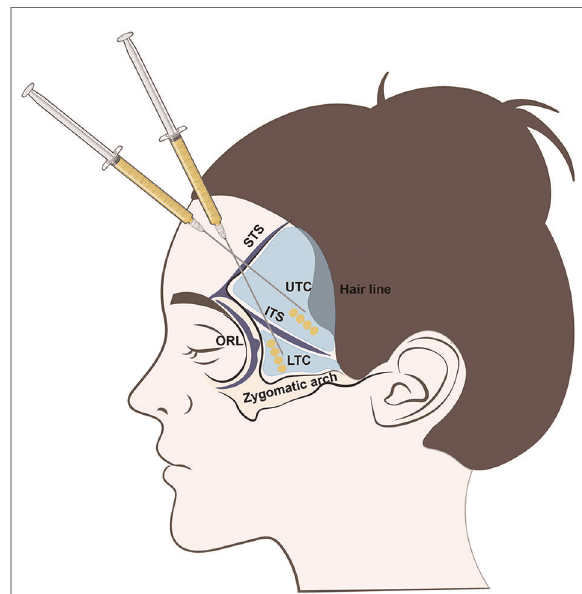
FIGURE 2 Illustration of temple fat grafting. LOFC, lateral orbital fat compartment; UTC, upper temporal compartment; LTC, lower temporal compartment; STS, superior temporal septum; ITS, inferior temporal septum; ORL, orbital retaining ligament; ZCL, zygomatic cutaneous ligament.